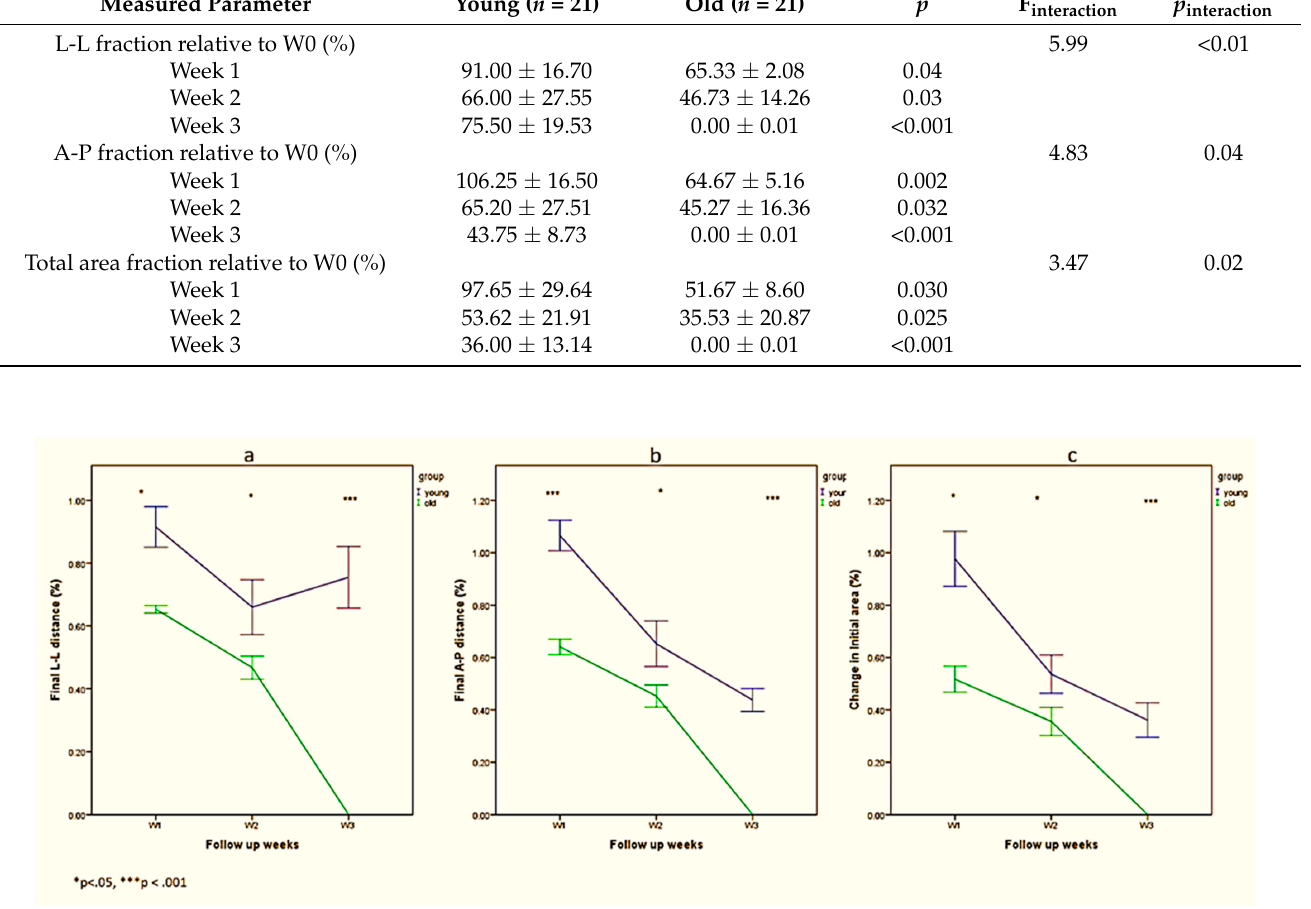
Figure 4. Differences between young and old rats in L-L fraction ( a ), A-P fraction ( b ) and total area fraction ( c ) relative to initial distance from week 1 to week 3; * p < 0.05, *** p < 0.001.